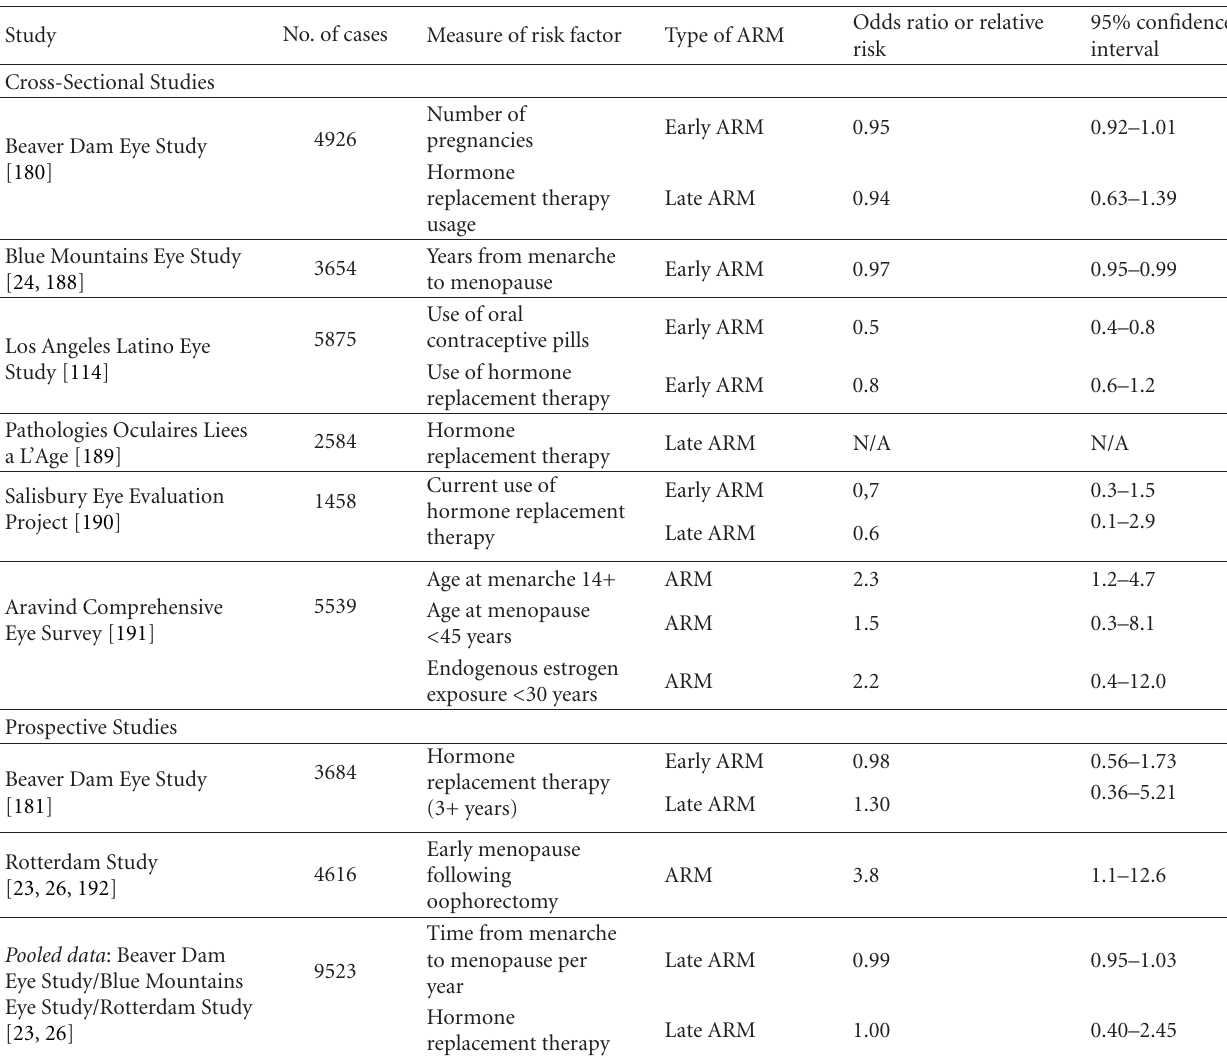
Table 7: Studies investigating the relationship between female sex hormones and risk for